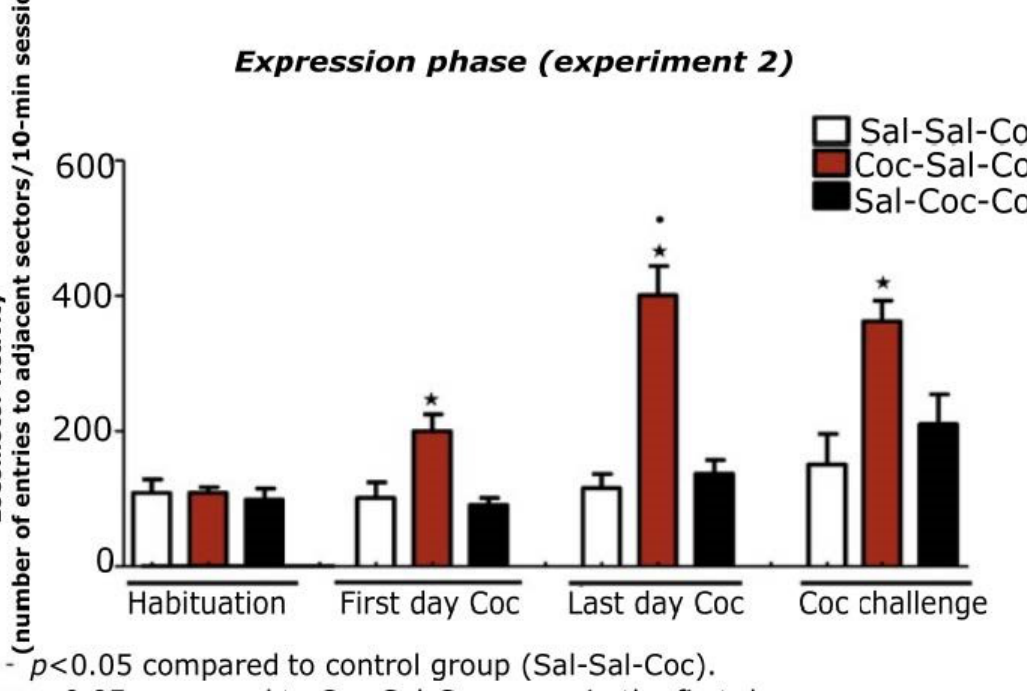
Figure 4. Locomotor activity of the animals in the expression phase during the habituation period, the first day of cocaine, the last day of cocaine, administered in a paired way (Coc-Sal-Coc) or not (Sal-Coc-Coc) to the environmental context, followed by the cocaine challenge after a not-handled 10-day period. The one-way ANOVA test was performed, followed by the Duncan post hoc test when necessary, and the GLM test for repeated measures to compare two measures of the same group at different times. Locomotor activity is expressed as mean ±